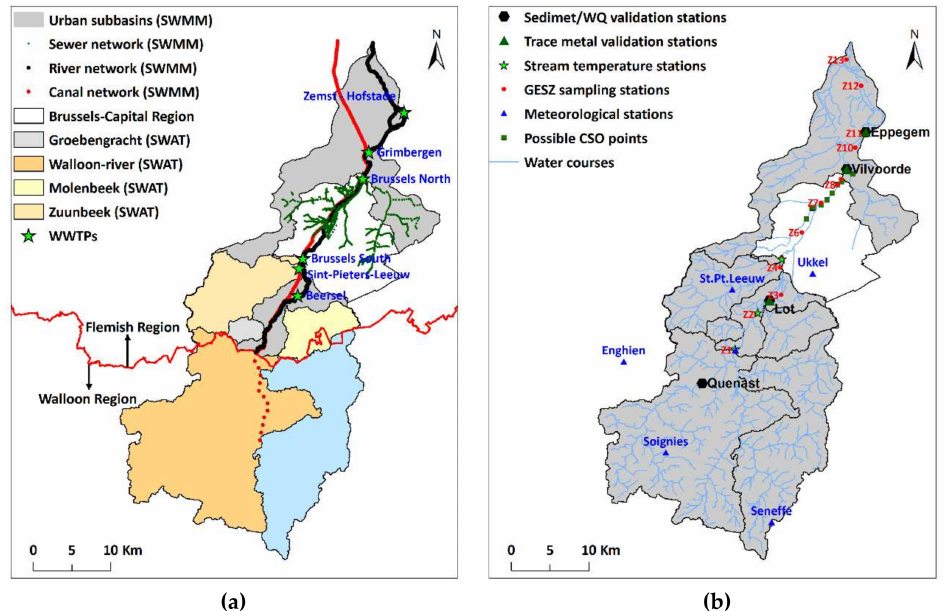
Figure 1. The Zenne basin with different sub-basins, river, canal and sewer network and locations of the Waste Water Treatment Plants ( a ); and locations of validation stations of different variables, possible Combined Sewer Overflow (CSO) points, sampling stations, meteorological stations and the river network ( b